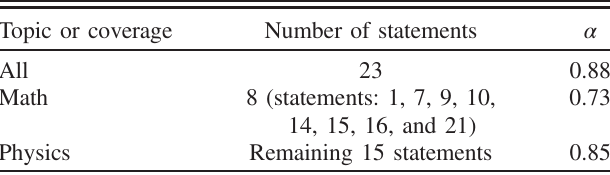
TABLE III. Topics, difficulty level, and coverage (whether that material was covered or not) for each of the 11 questions.